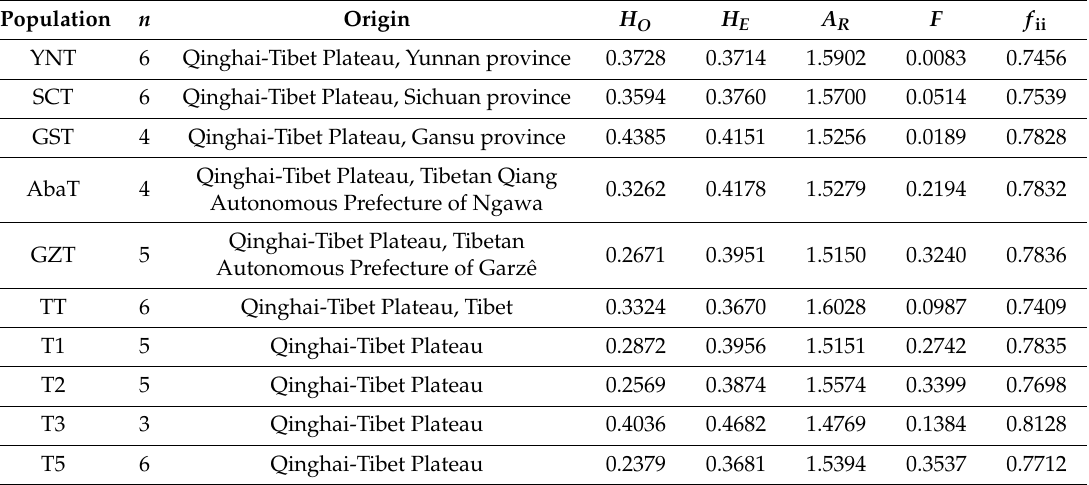
Table 1. Genetic diversity in 10 Tibetan pig